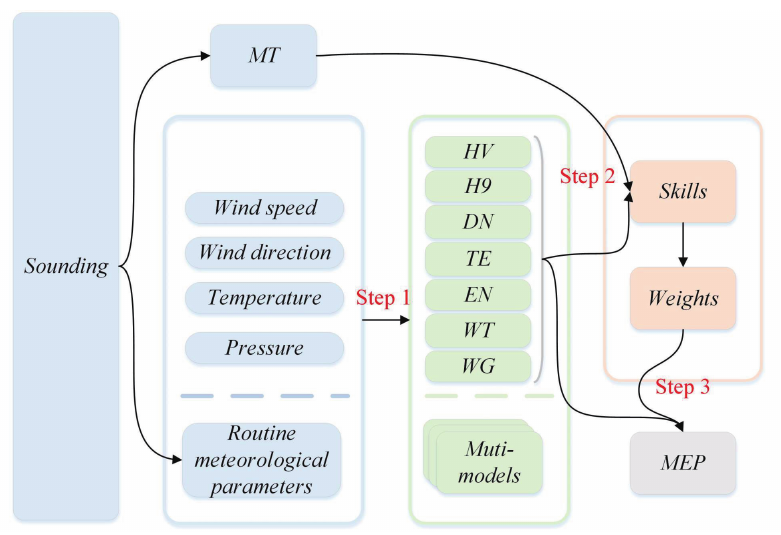
Figure 2. Process of MEP. Abbreviation meanings are as follows after this. MT: micro-thermal; HV: Hufnagel-Valley 5/7; H9: Hmnsp99; DN: Dewan; TE: Thorpe; EN: Ellison; WT: WSPT; WG: WSTG; MEP or ME: multi-model ensemble pattern